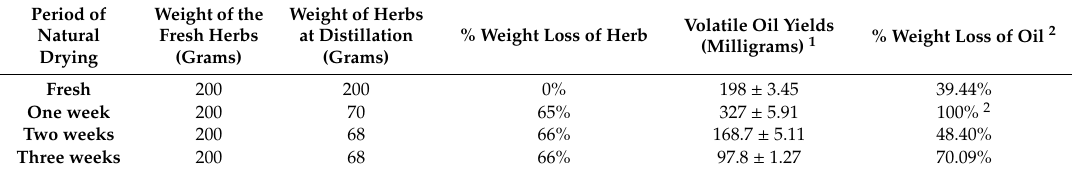
Table 1. E ff ects of natural drying on weights and oil yields from the rosemary